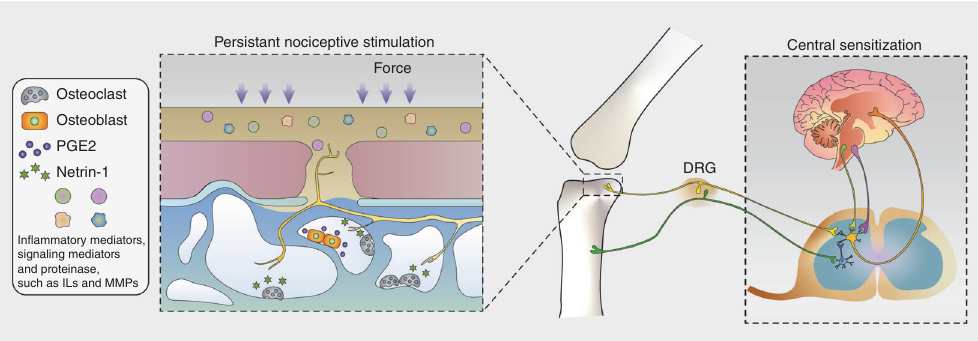
Fig. 5 Schematic diagram of OA pain. Osteoclast-derived netrin-1 guides sensory nerve innervation in the osteochondral area, and multiple signaling mediators give rise to persistent nociceptive stimulation. The continuous input of pain signals causes central sensitization, suppresses the descending inhibitory system, and brings sympathetic referred pain away from the area of the arthritis